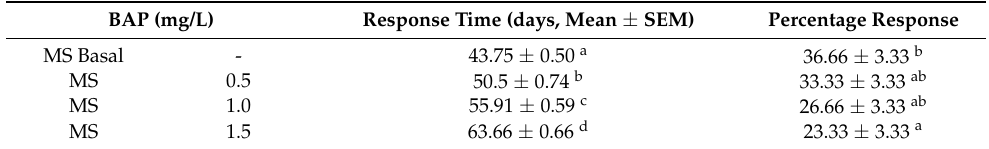
Table 3. In vitro rhizome formation in A. chasmanthum . Effect of different concentrations of MS basal media and MS media augmented with BAP on in vitro rhizome formation.